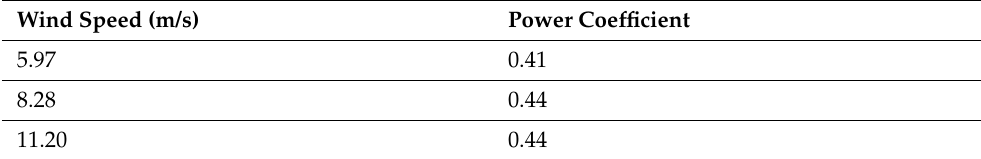
Table 3. Values of C p according to chosen wind speeds.